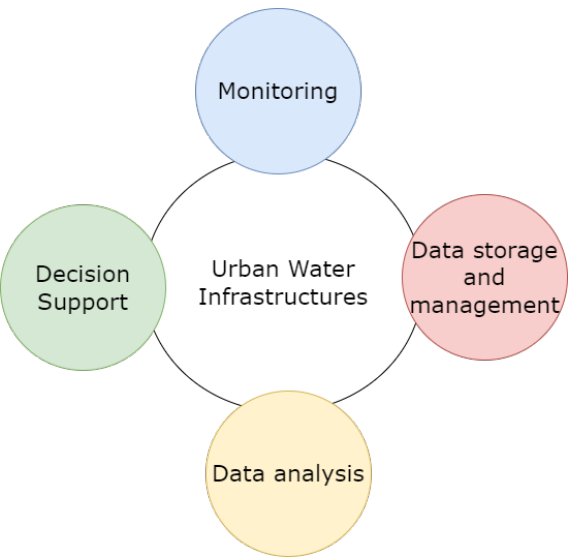
Figure 7. Urban water infrastructures management areas of